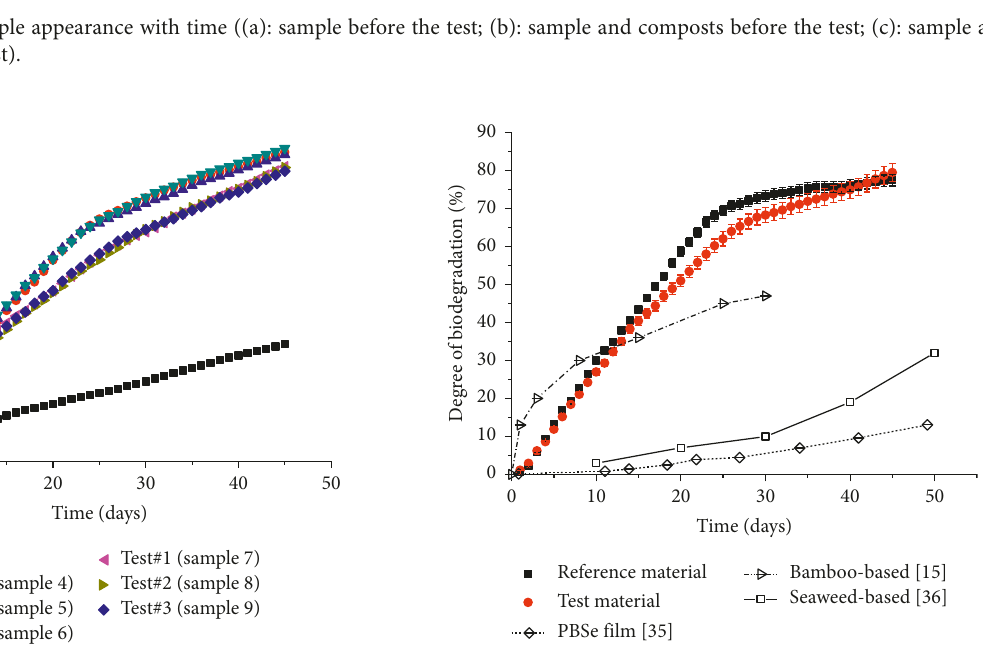
Figure 10: Biodegradation estimation: comparative plot of bio- Figure 9: Accumulated CO 2 production in the “blank” vessel with degradation rate with respect to reference material (averaged over only compost, and vessels of test materials. three samples each) and literature [15, 35, Table 3: Test methods and results for the mechanical property characterization.